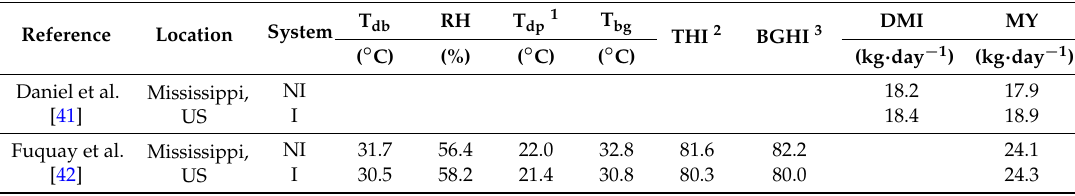
Table 2. Meteorological and thermal stress attributes and physiological response of dairy cows for non-insulated (NI) and insulated (I) shades.